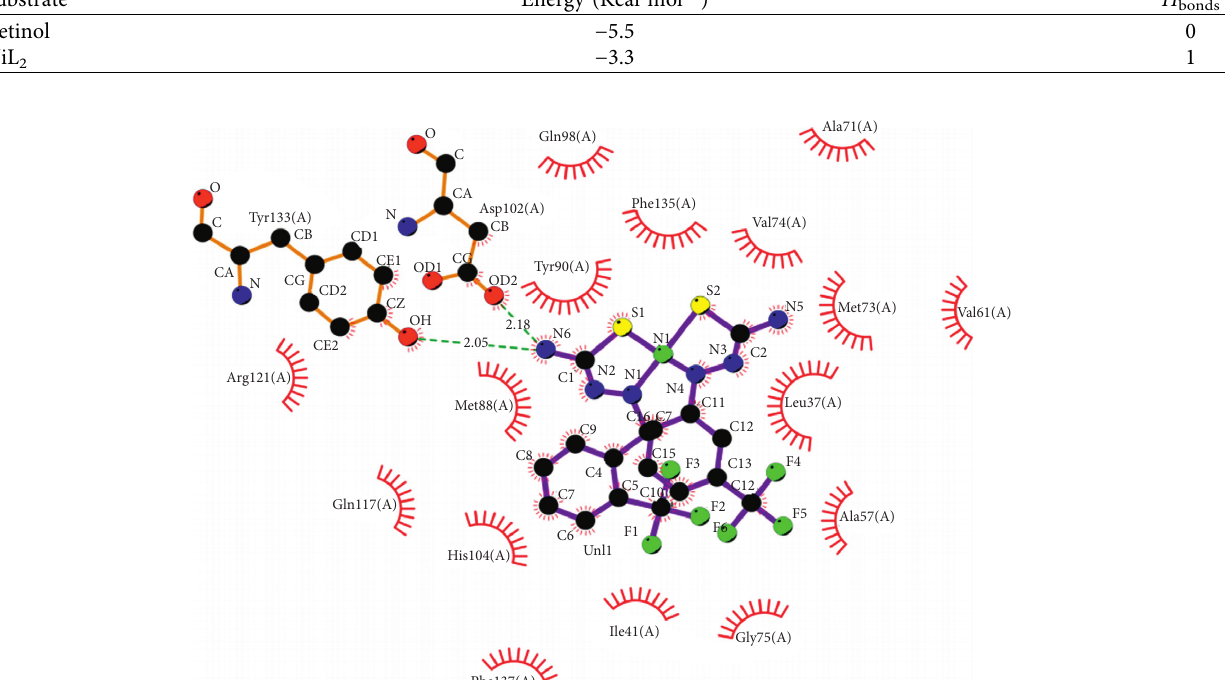
Figure 9: Intermolecular hydrogen bonds of NiL 2 complex with both Tyrosine 133 and Aspartate 102 at the active site of